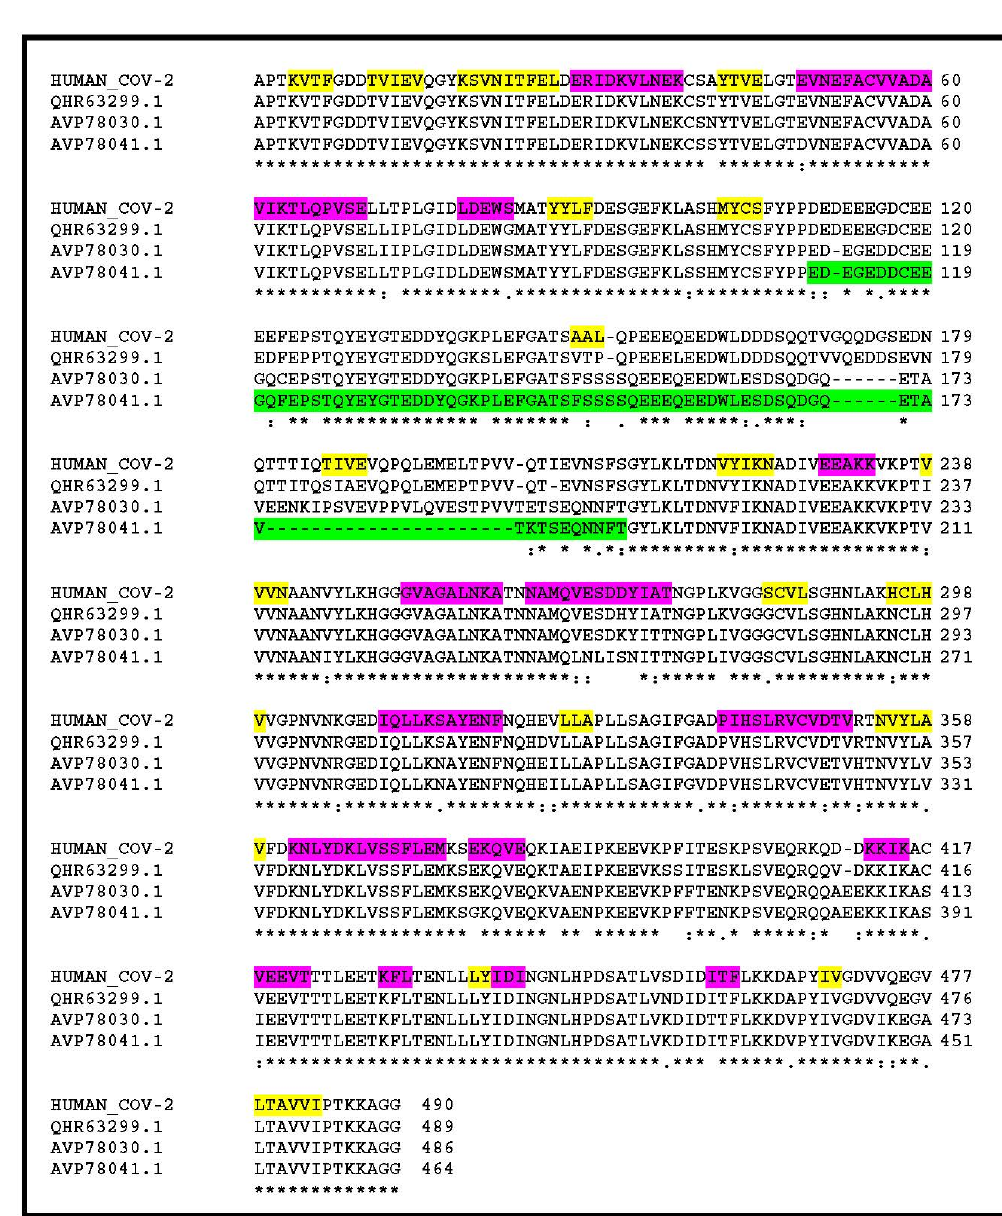
Figure 1. Multiple alignment of the human SARS-CoV-2 nsp3 N-terminal sequence and that of its 3 closest homologs in non-human-infecting coronaviruses. Sequences with accession #: QHR63299.1, AVP78030.1, AVP78041.1 are from 3 different isolates of bat-associated viruses. Their overall similarity over the entire SARS-CoV-2 nsp3 sequence are 93%, 83.3%, 80.9% identical residues, respectively. It goes down to 44% identity in the “variable region” highlighted in green. Predicted secondary structure elements are highlighted in yellow (extended) and purple (helix). The segment highlighted in green is predicted as intrinsically disordered. HUMAN_COV-2 corresponds to Genbank accession #: